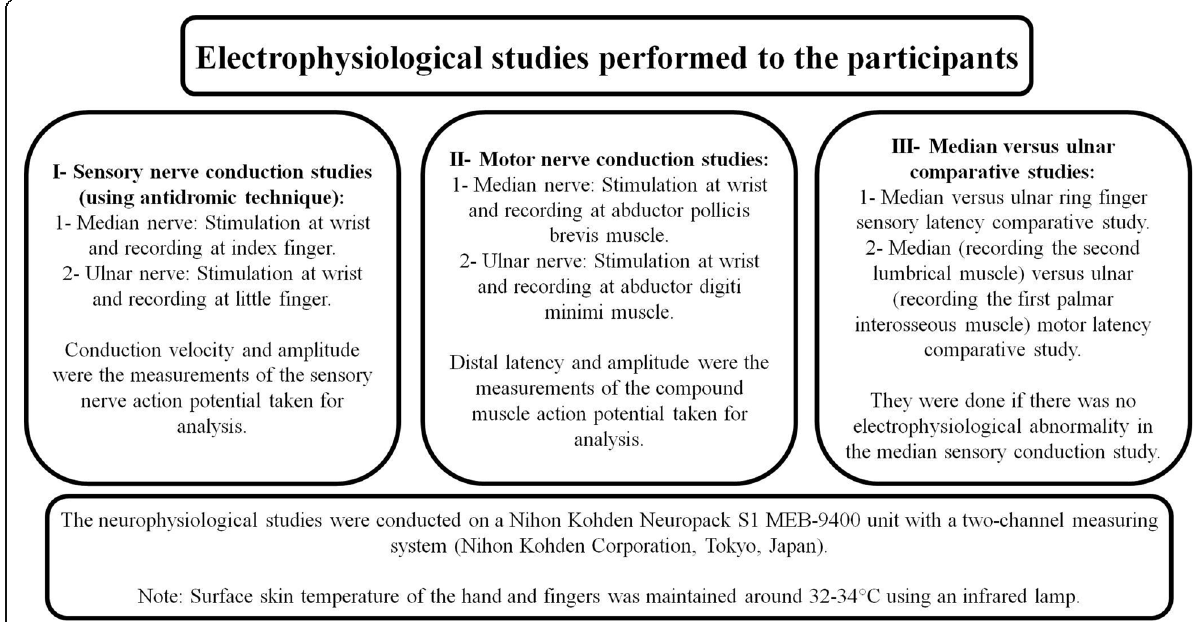
Fig. 4 Illustration of the electrophysiological studies performed to the participants [14, 16, 17, 21]